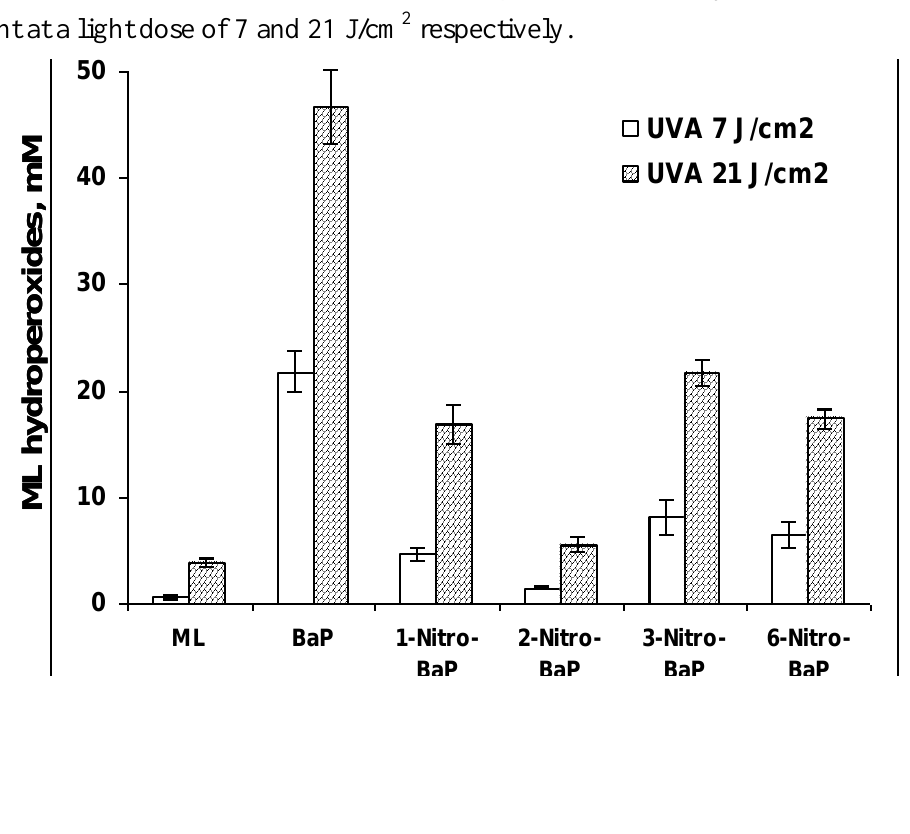
Figure 3. Lipid peroxidation induced by photoirradiation of BaP, 1-nitro-BaP, 2-nitro-BaP, 3-nitro-BaP, and 6-nitro-BaP in methanol in the presence of methyl linoleate (ML) with UVA light at a light dose of 7 and 21 J/cm 2